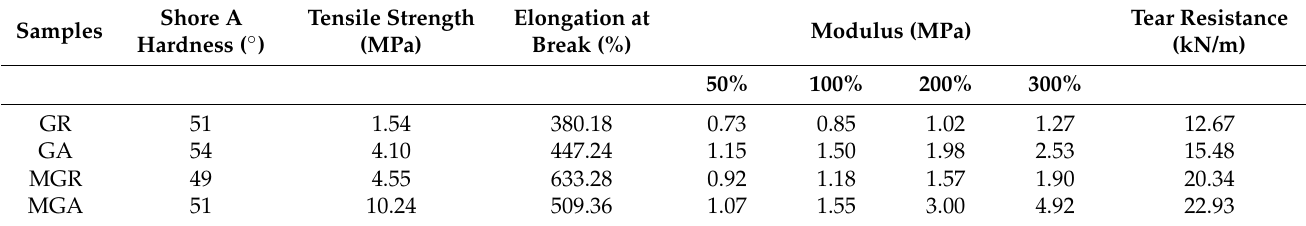
Table 4. Mechanical property of coal gangue/SBR